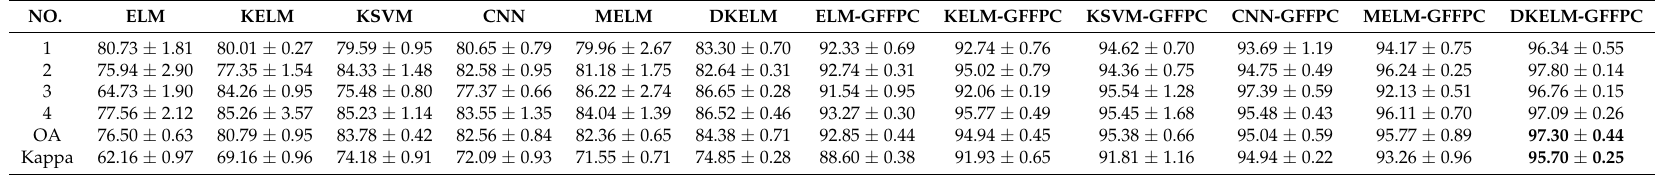
Table 8. Classification Accuracy(%) of the comparison and proposed algorithms in Glycine ussuriensis Dataset.